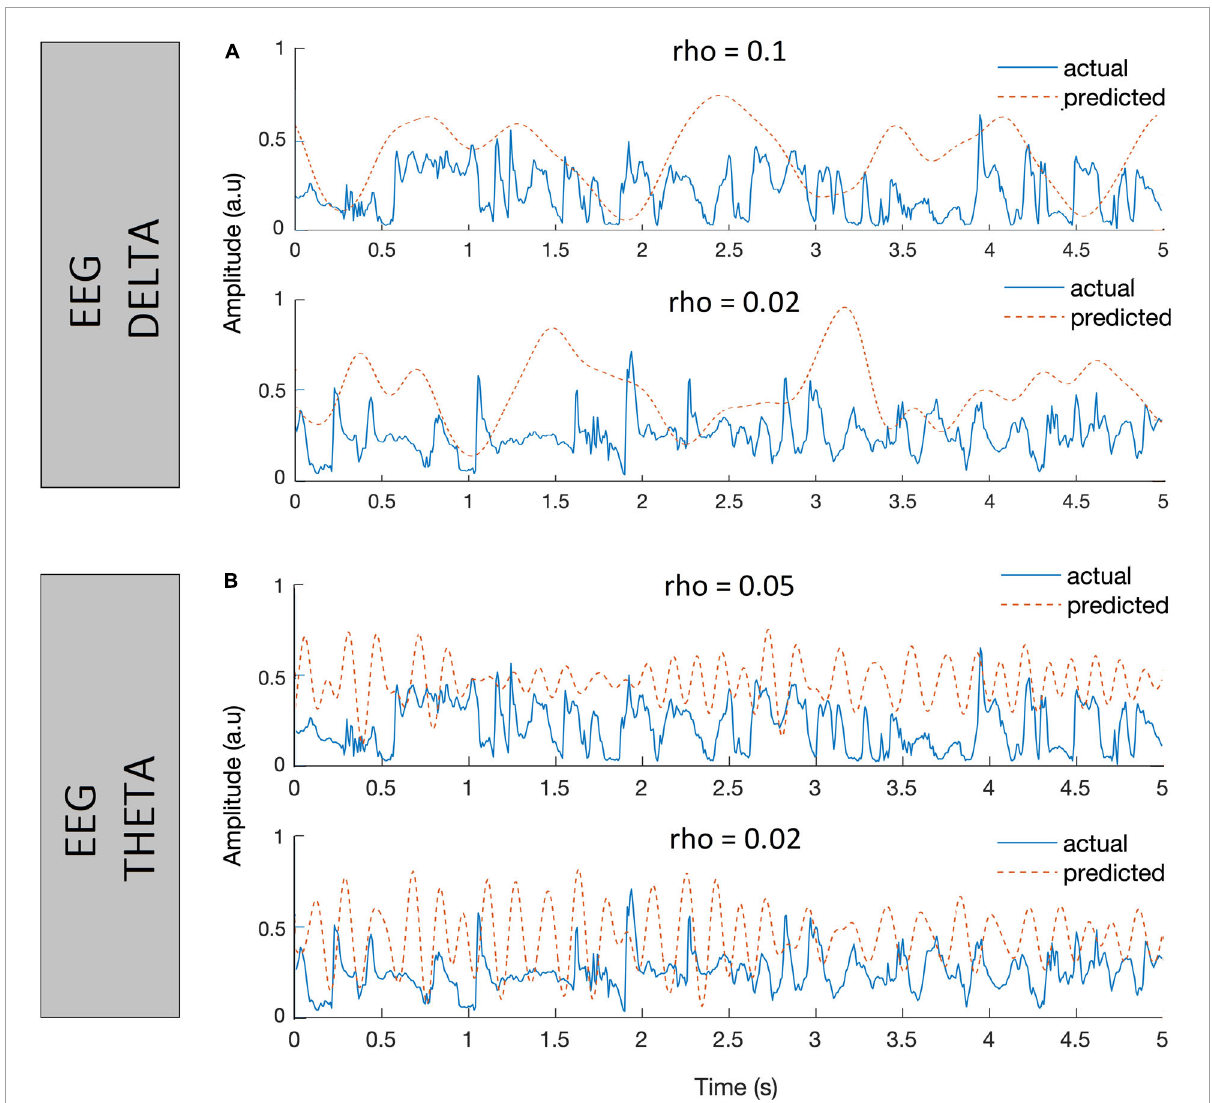
FIGURE6 Plots showing instances of actual speech envelopes (blue) and the reconstructed envelopes (red dotted) and bootstrapped Spearman correlation ( rho ) between them. The decoders were trained using EEG in delta (A) and EEG in theta bands (B) , with speech envelope < 40